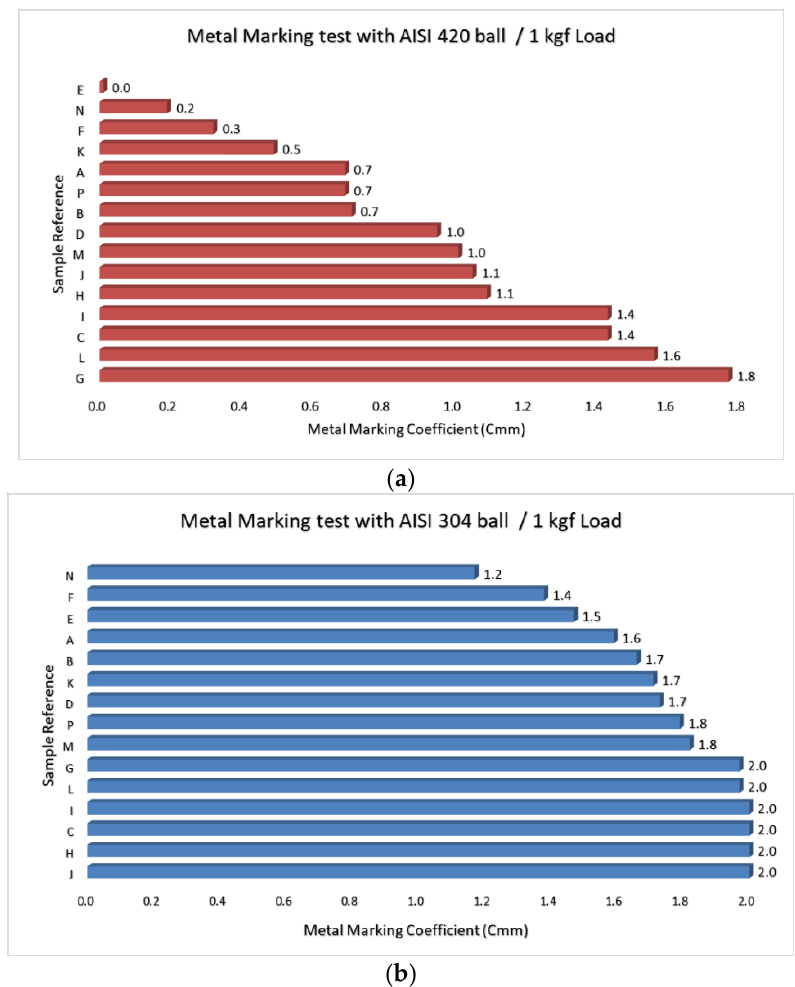
Figure 16. Comparative dispersion of metal marking coefficient (C mm ) on a representative batch of